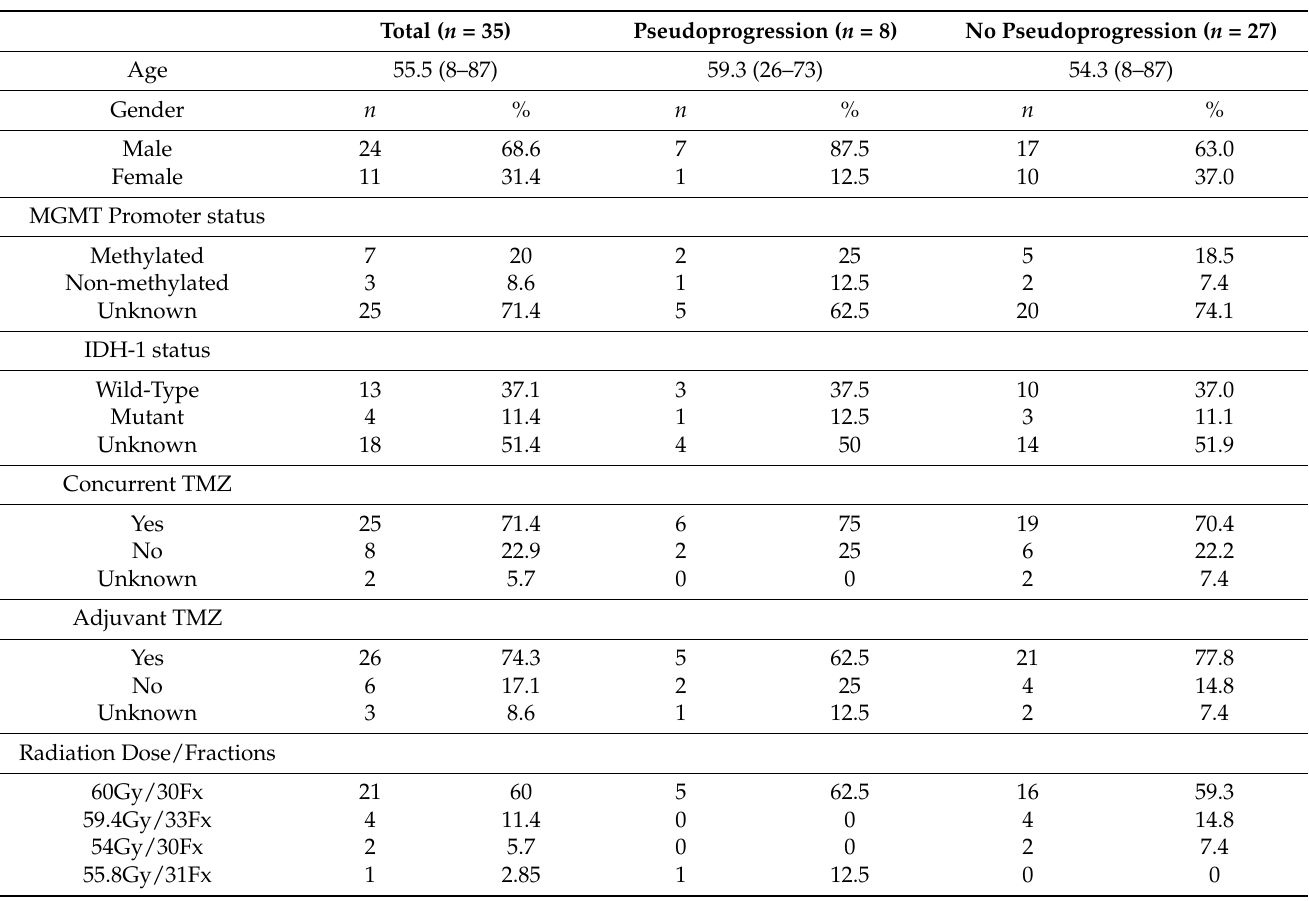
Table 1. Patient demographics of the study population. Clinical features of chemotherapy, radiation dose, location, and extent of resection are included as well. MGMT: O6-methyl-guanine methyl transferase; IDH: isocitrate dehydrogenase; TMZ: temozolomide; Gy: Gray; Fx: fractions; GTR: gross total resection; NTR: near-total resection; STR; sub-total